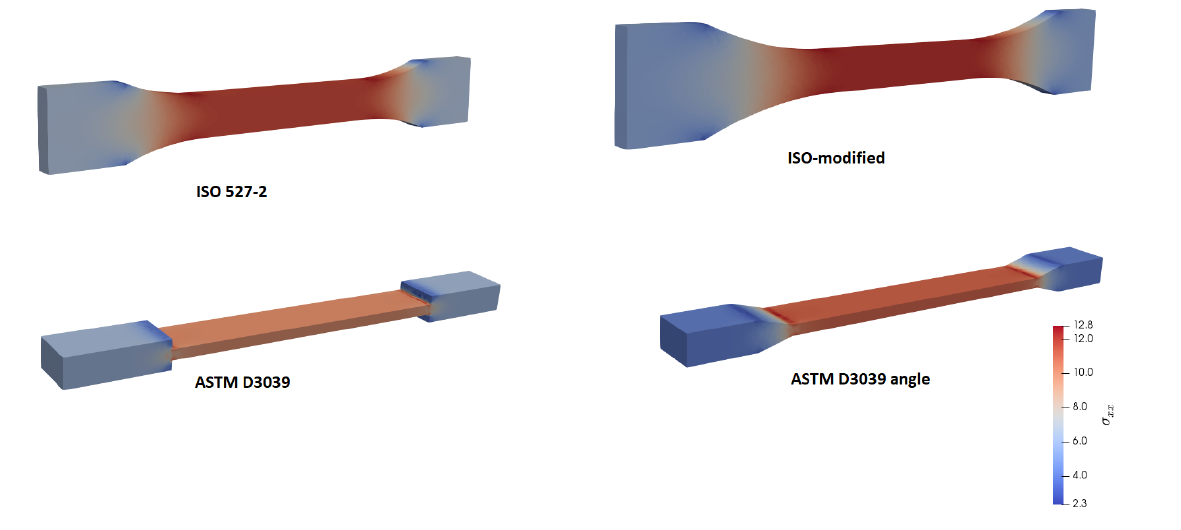
Figure 6. Simulation of uniaxial tensile tests, stress distribution, σ xx , (in color) resulted in all investigated